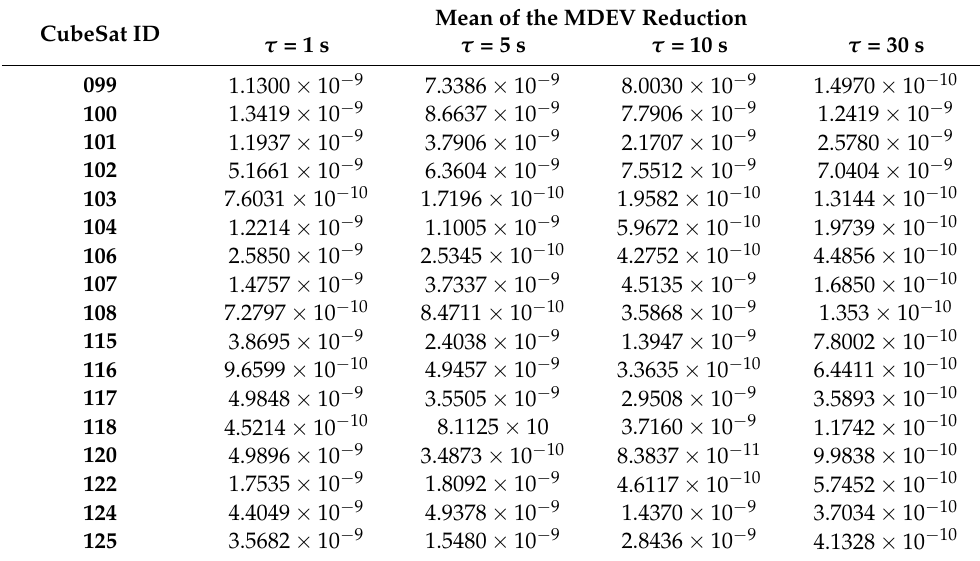
Table 5. Mean values of the MDEV reductions after applying new PCV patterns in the RD-POD for short averaging